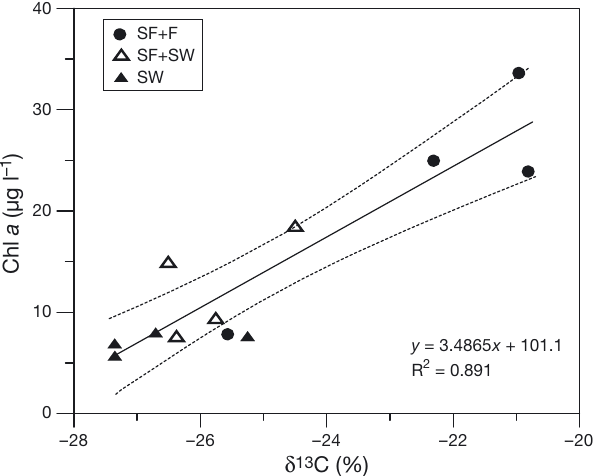
Fig. 6. Relationship between δ 13 C (‰) of particulate organic matter and chlorophyll a concentration in 3 different aqua- culture areas (see Fig. 1) of Sanggou Bay during the wet